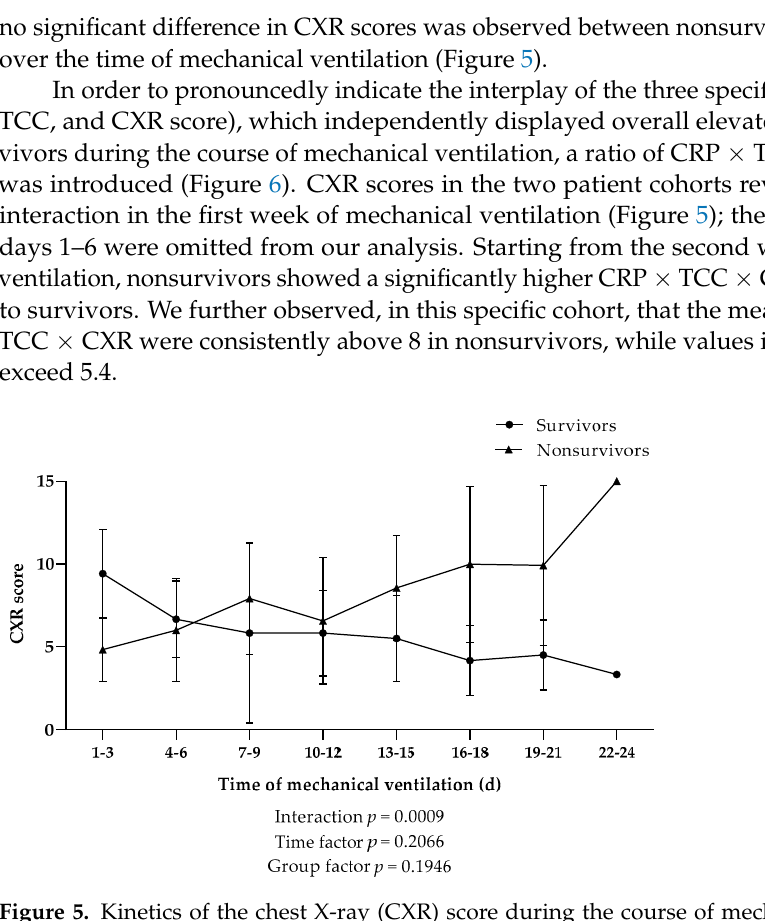
COVID-19 patients that survived ( n = 4) or died ( n = 7). Data are shown as mean ± SD. Dotted Figure 5. Kinetics of the chest X-ray (CXR) score during the course of mechanical ventilation in